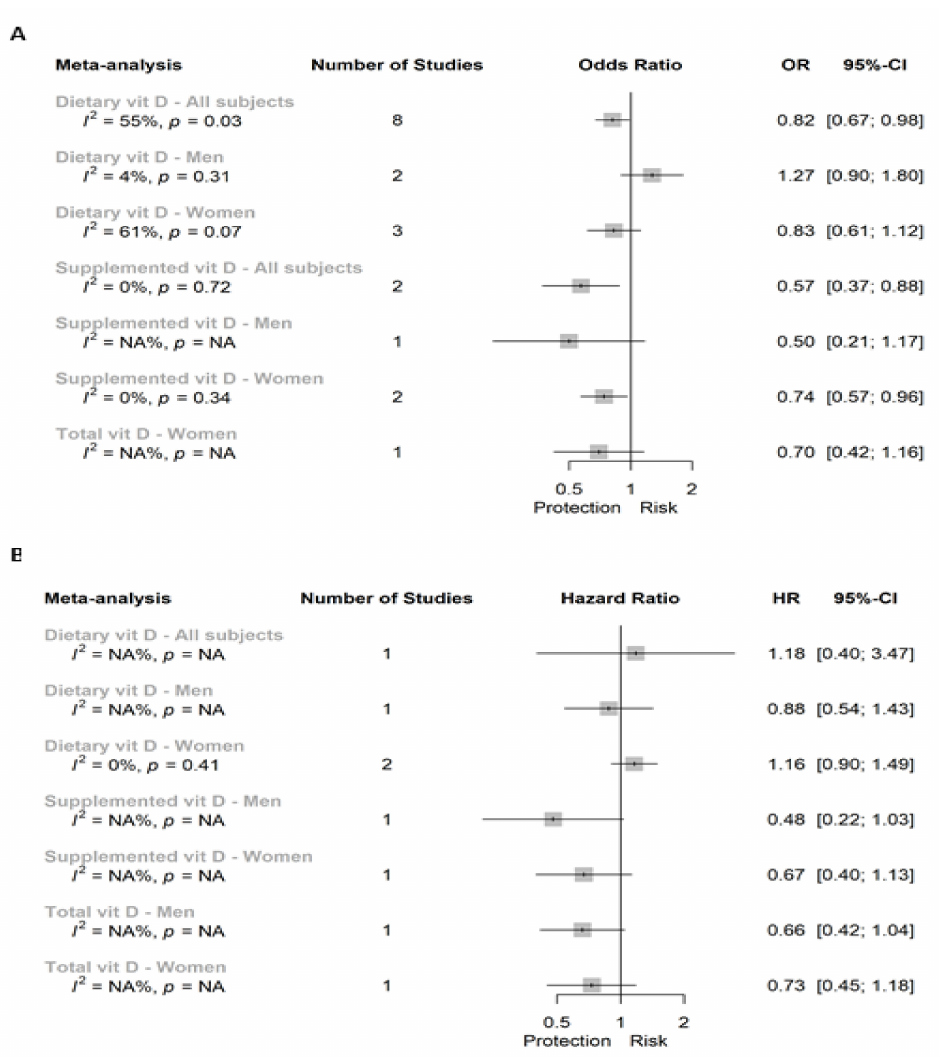
Figure 4. Super plot of ( A ) case-control and ( B ) prospective cohort studies assessing the association between vitamin D intake (highest versus lowest categories) and the risk of colon